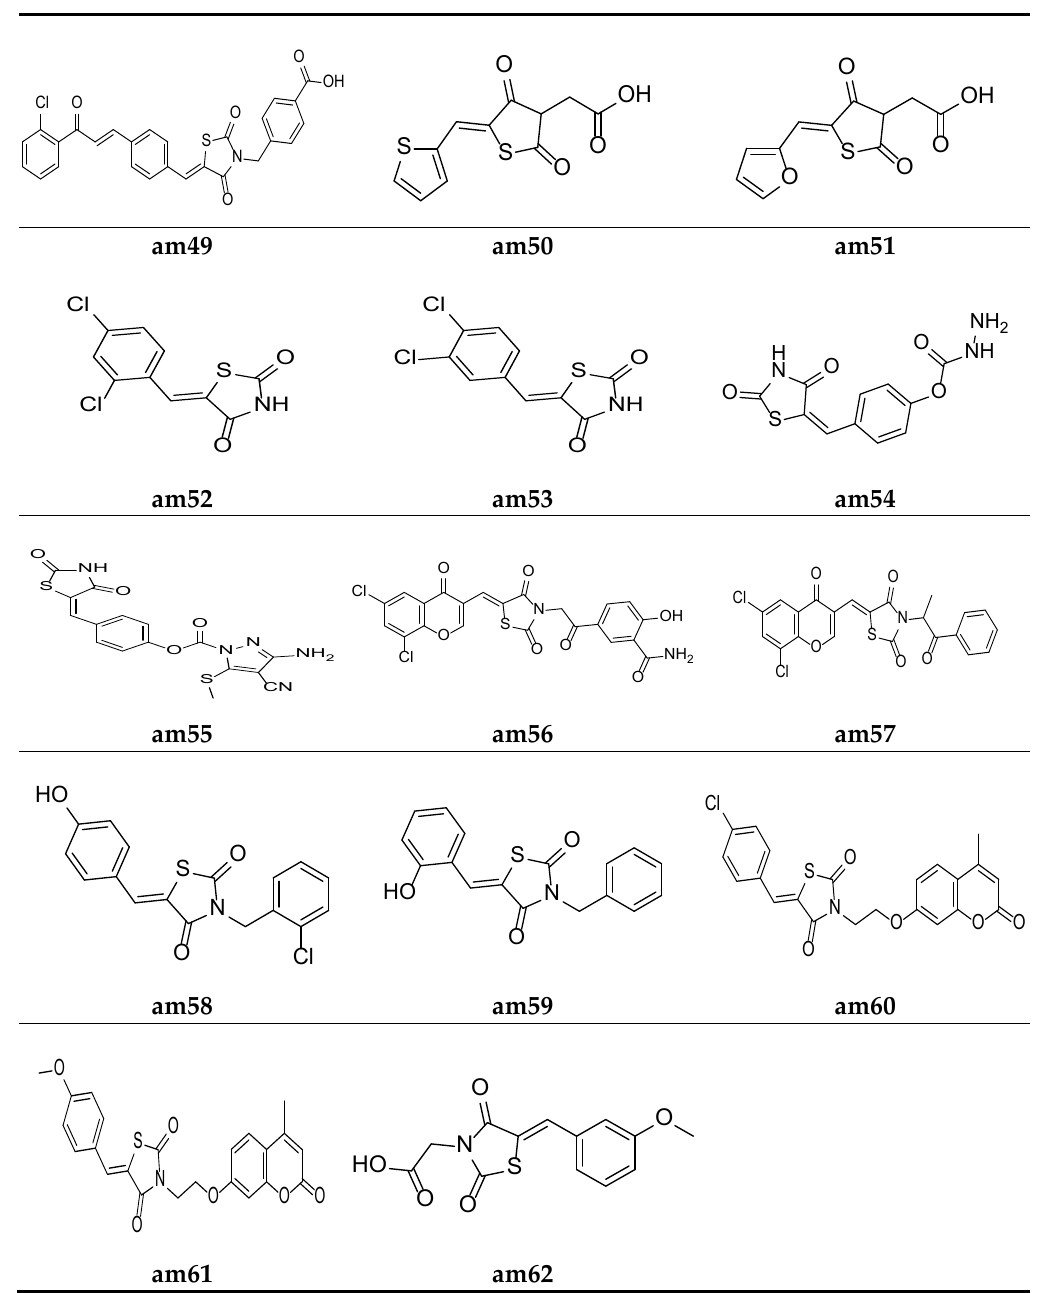
Table 25. Antimicrobial screening results of the compounds ( am54 – am55 ).